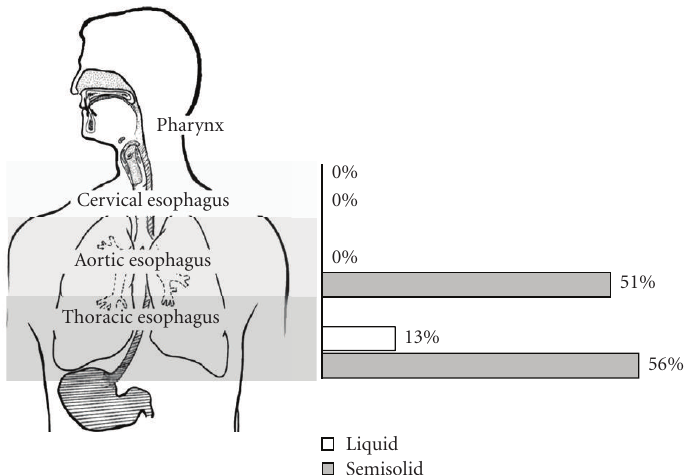
Figure 1: Regions of the esophagus defined by anatomic location and percentage of IES occurring with liquid and semisolid barium in the upright position.